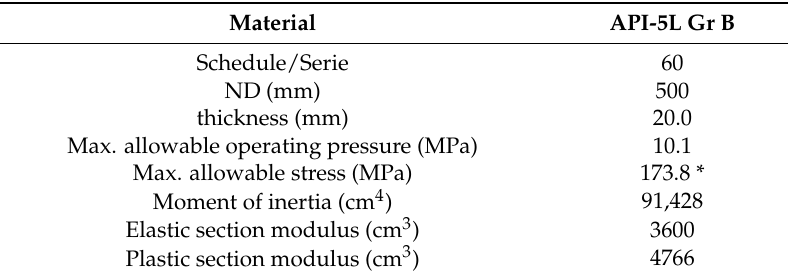
Table 1. Material specifications of the pipeline according to ANSI/ASME B.31.4.